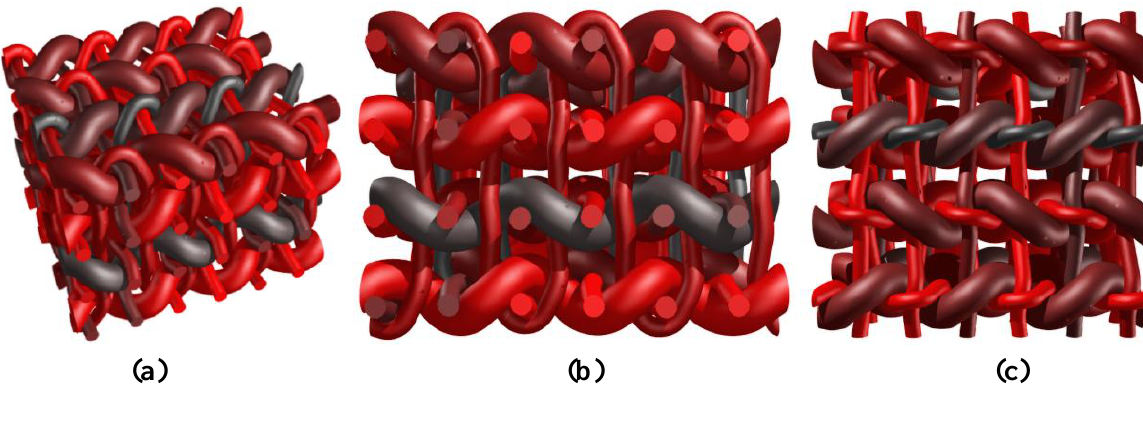
Figure 13. Generation of a 3D reinforced composite similar to that studied in [22]. ( a ) Axonometric view; ( b ) side view illustrating binders in thickness direction; and ( c ) top